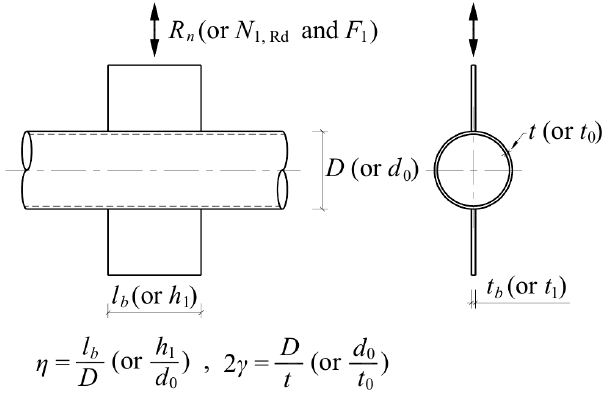
Figure 1. Geometrical configuration of plate-to-circular hollow-section X-joint (CHS XP).